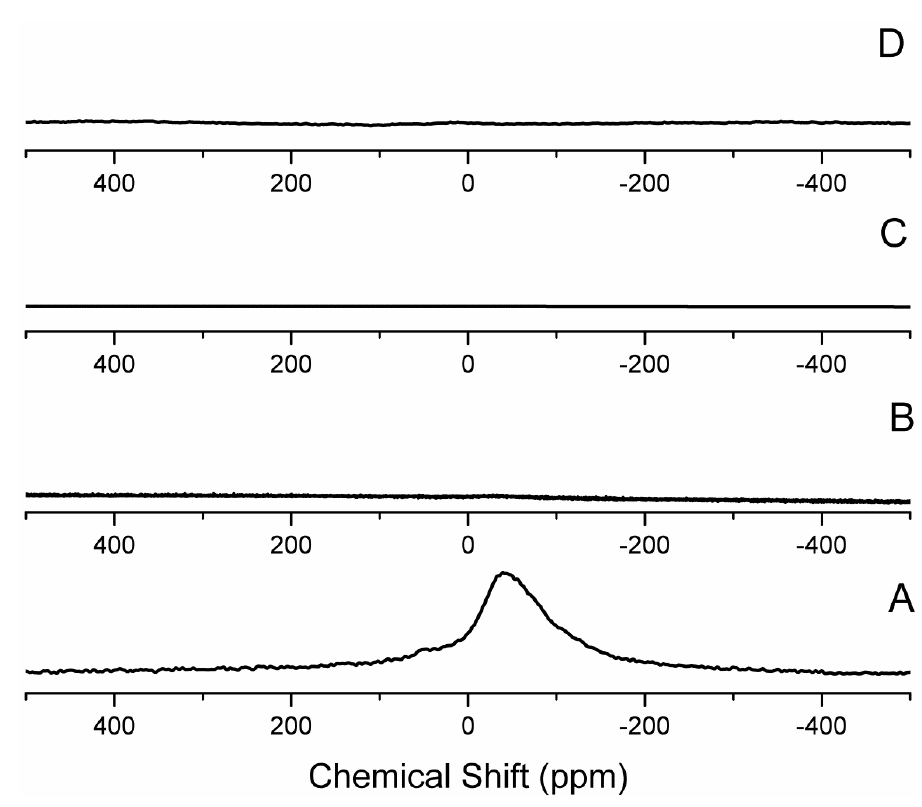
Figure 10. 23 Na MAS NMR spectra of ( A ) Na + MMT; ( B ) CG-MMT 3:1; ( C ) NG-MMT 3:1; and ( D ) NG-MMT